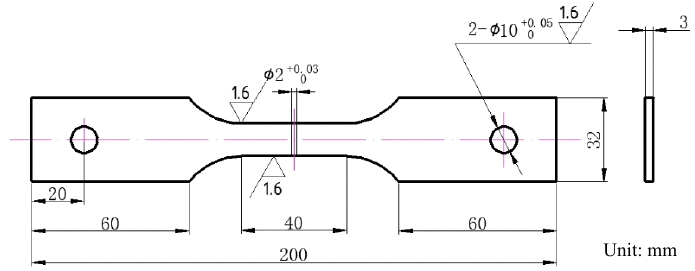
Figure 3. The sample size of aluminum